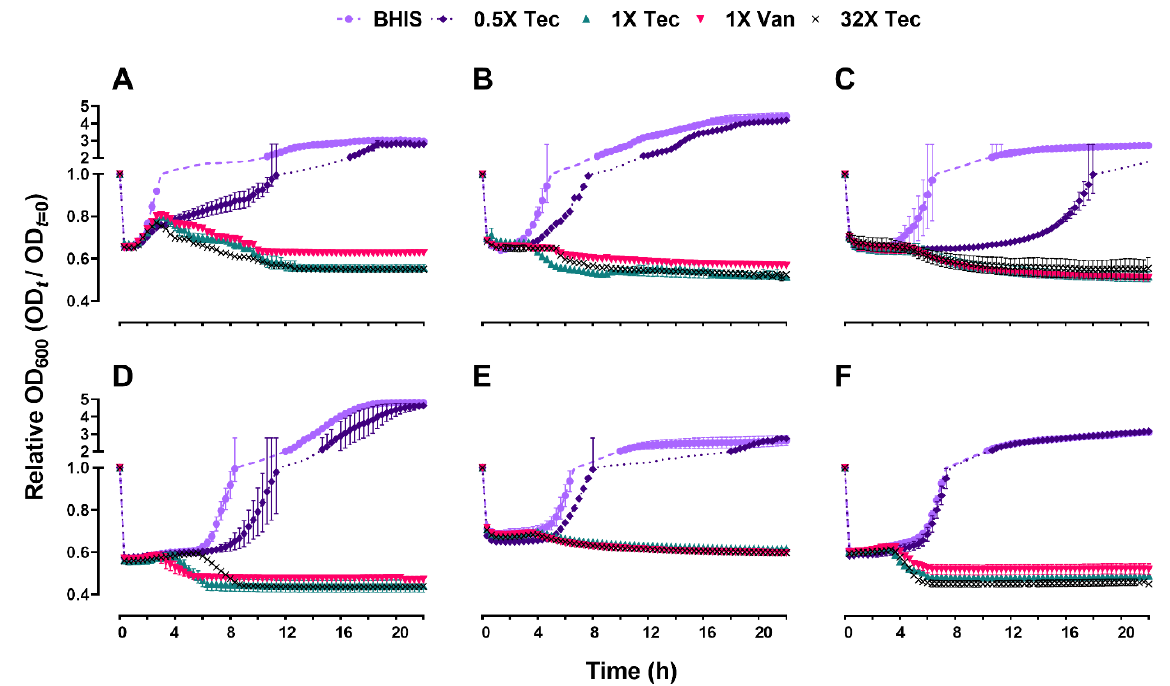
Figure 3. Teicoplanin and vancomycin at MIC inhibit spore outgrowth, while sub-MIC teicoplanin substantially delays outgrowth. Data points represent the mean of the relative OD 600 at the indicated time points normalized to t = 0 (control). All the experiments were performed in triplicates and error bar represents the standard errors. The results include the strains: ( A ) F101; ( B ) F102; ( C ) A125; ( D ) A126; ( E ) R20291; ( F ) H203. Circle ( • ), diamond ( (cid:7) ), triangle ( ▲ ), inverted tringle ( ▼ ), and cross (×) denote the exposure to BHIS, 0.5× MIC teicoplanin, 1× MIC teicoplanin, 1× MIC vancomycin, and 32× MIC teicoplanin, respectively. Abbreviations: Tec = teicoplanin, Van = vancomycin, BHIS = Brain heart infusion broth supplemented with 0.1% sodium taurocholate. The dashed and dotted lines represent the data trend between the Y-axis break.